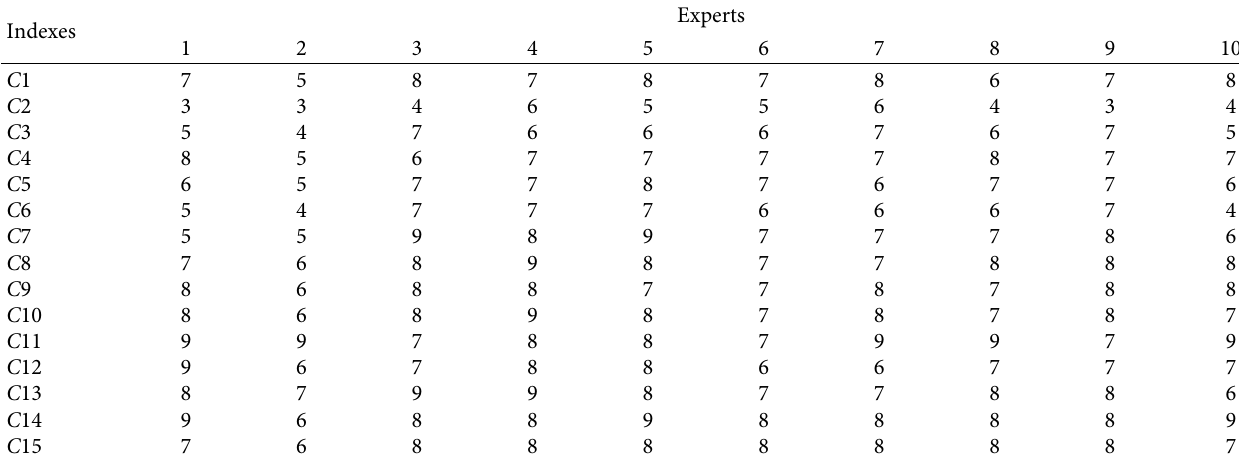
Figure 6: Cloud model diagram of comprehensive ability evaluation standard for accounting applied talents. Table 5: Results of the expert’s scoring for the classmate.